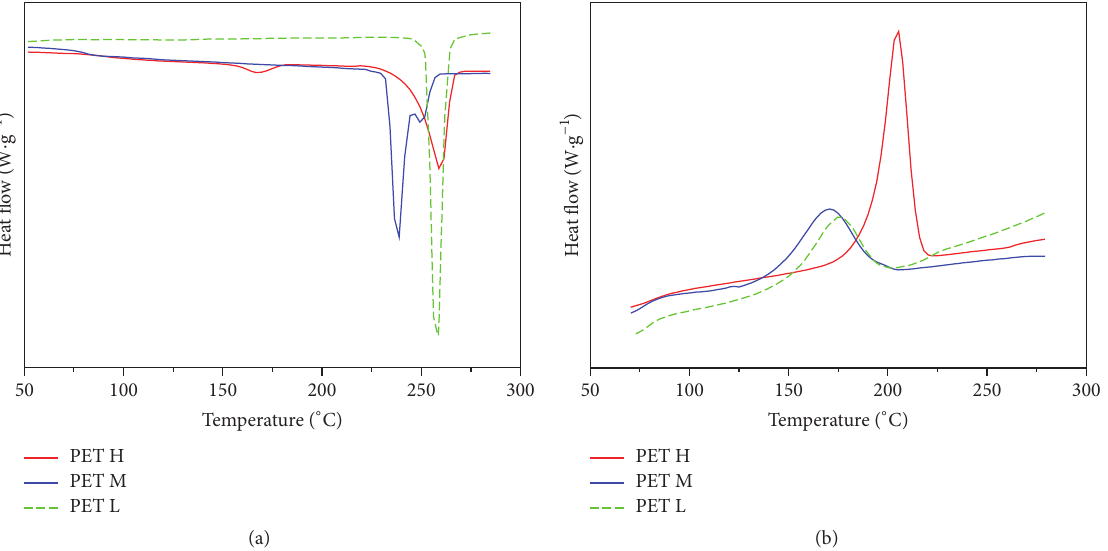
Figure 3: DSC traces of different PET grades: (a) heating trace; (b) cooling trace, indicating melting and crystallization behaviour of PET grades L, M, and